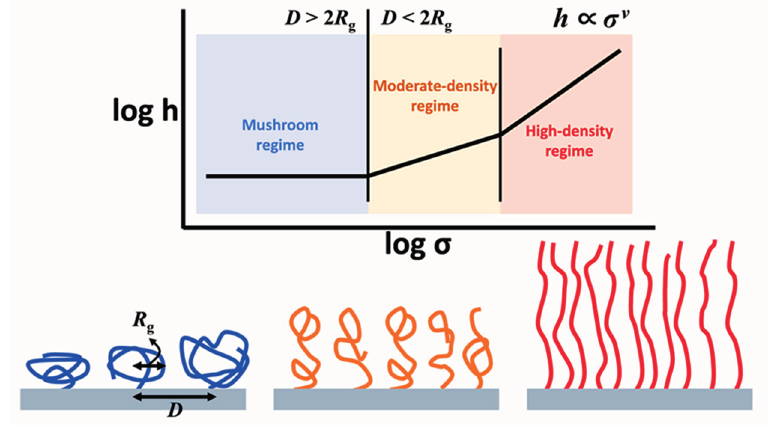
Figure 8. Schematic depicting scaling law for brush thickness and grafting